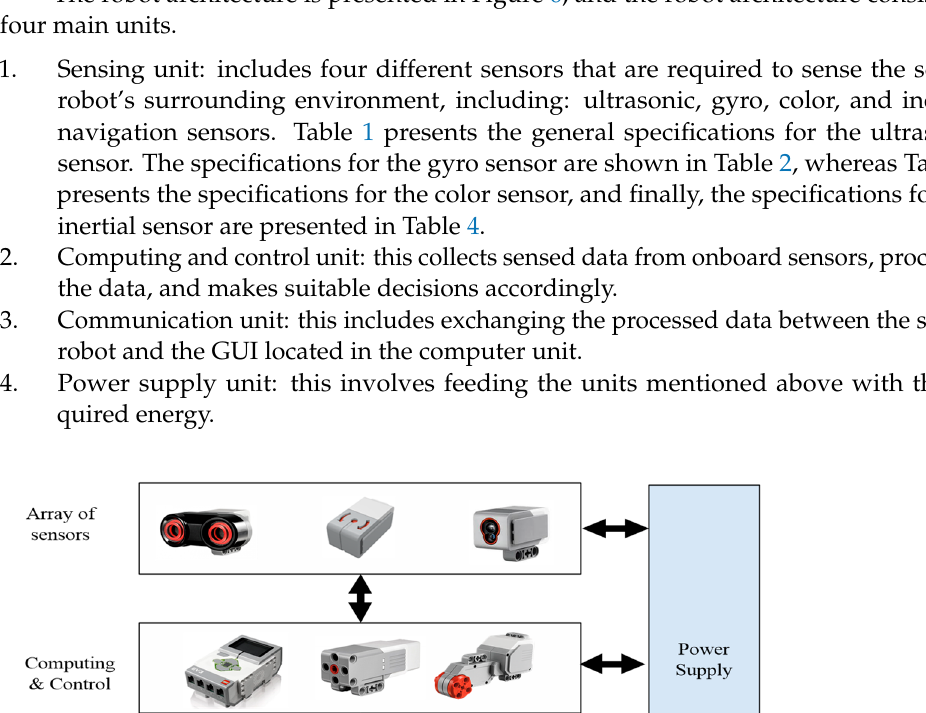
Table 2. General specification parameters for the gyro sensor.